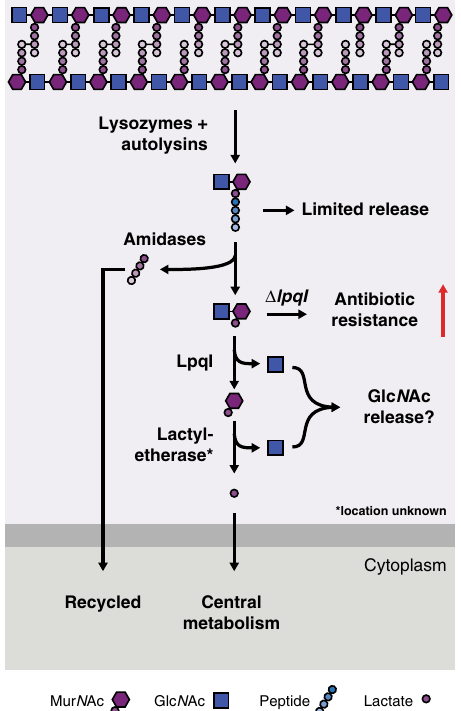
Fig. 6 Peptidoglycan recovery pathway in pathogenic mycobacteria. Based on our observations we can propose the following model for PG recycling and recovery in mycobacteria. Cleavage of the cell wall by endogenous autolysins or host-derived lysozyme generates muropeptides. Some of this material undergoes limited release to stimulate the host immune system. The remainder are subsequently degraded by amidases and other peptidases. LpqI then cleaves Glc N Ac-Mur N Ac, which is followed by D -lactyl-ether cleavage. Lactate can then be used by the cell under aerobic conditions and Glc N Ac (or its derivatives) are most likely